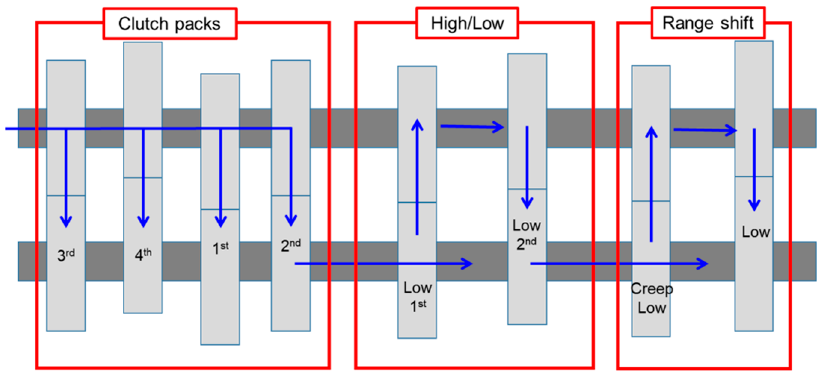
Figure 1. The schematic diagram of the gear stages of PST.